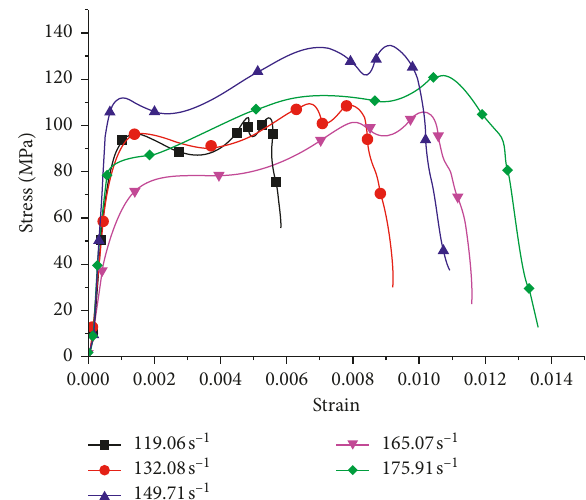
Figure 2: Typical stress-strain curves of parallel-bedding shale samples at different strain rates.